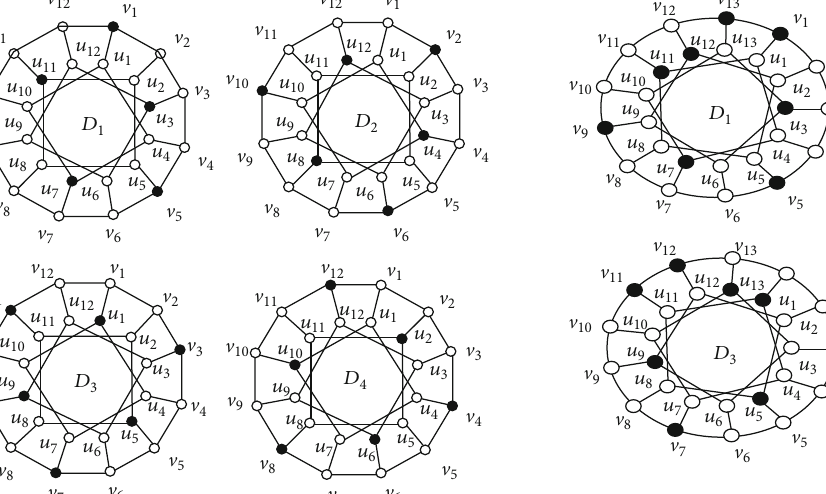
P ð 12, 3 ÞÞ = γ ð P ð 12, 3 ÞÞ = 6 . Figure 13: γ ∞ m ð